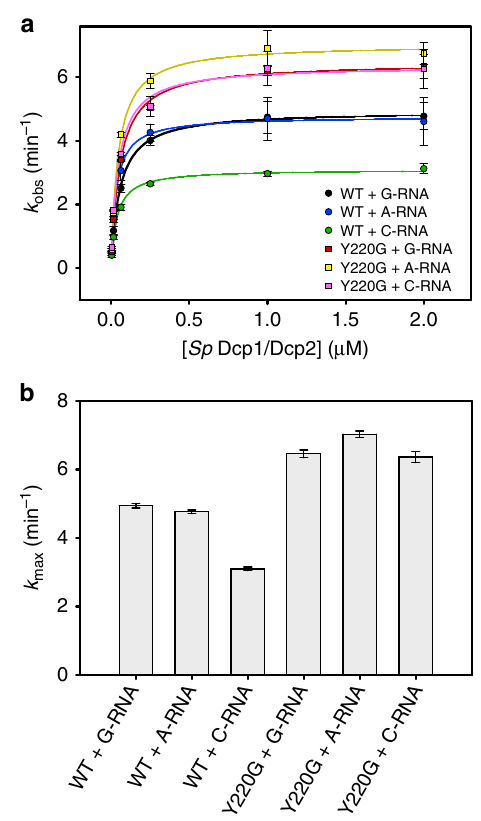
Fig. 4 Dcp2 selectivity for the fi rst transcribed nucleotide of RNA depends on Tyr220 ( Kl Phe223). a Plots of k obs for decapping a 29-mer RNA substrate with G, A, or C as the fi rst transcribed nucleotide (G-RNA, A- RNA, C-RNA, respectively), with WT or Tyr220Gly S . pombe Edc1 – Dcp1 – Dcp2 complex versus enzyme concentration. The concentration of the Dcp1 – Dcp2(1 – 243) complex is varied, with Edc1(155 – 180) coactivator peptide kept at saturating concentration (50 µ M). Errors on k obs are s.d. of two independent replicates. b Bar graph showing k max values determined from k obs versus enzyme concentration plots in ( a ). Errors are standard error of the fi ts to determine k